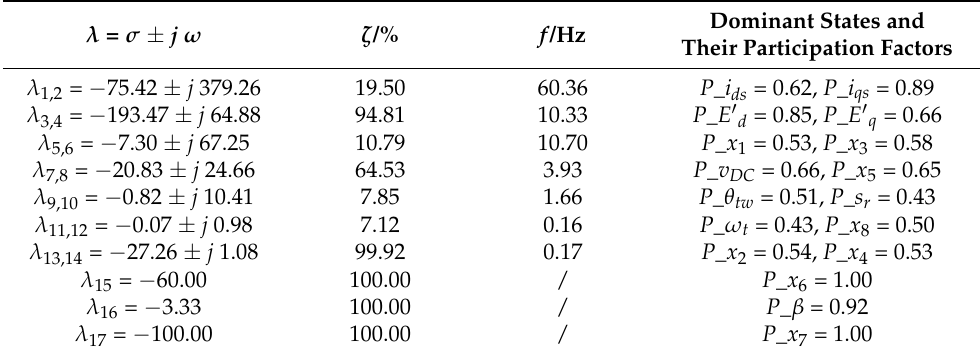
Table 1. Eigenvalues and dominant participation factors.